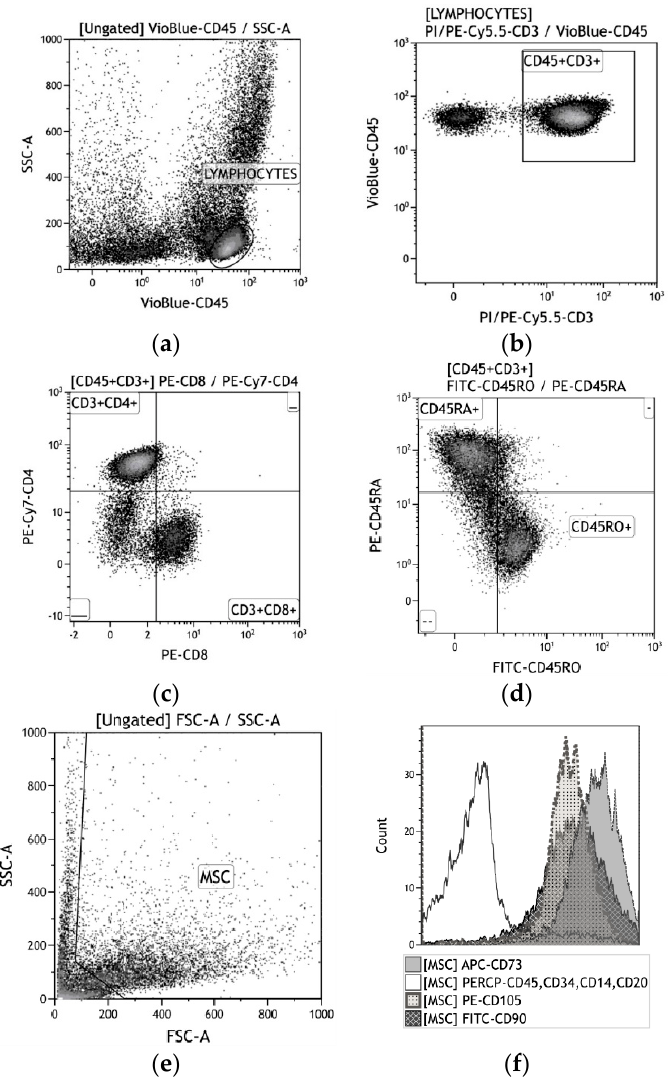
Figure 2. A strategy for gating live human blood mononuclear cells (hBMNC) subsets ( a )–( d ) and human adipose-derived stem cells (hAMSCs) ( e )–( f ). ( a ) CD45 + leukocytes; ( b ) CD45 + CD3 + T cells; ( c ) CD4 + vs. CD8 + T cells; ( d ) CD45RA + vs. CD45RO + T cells; ( e ) MSC identification based on forward scatter (FSC) vs. side scatter (SSC); ( f ) CD73 + , CD90 + , and CD105 + vs. CD14 + CD20 + CD34 + CD45 + .